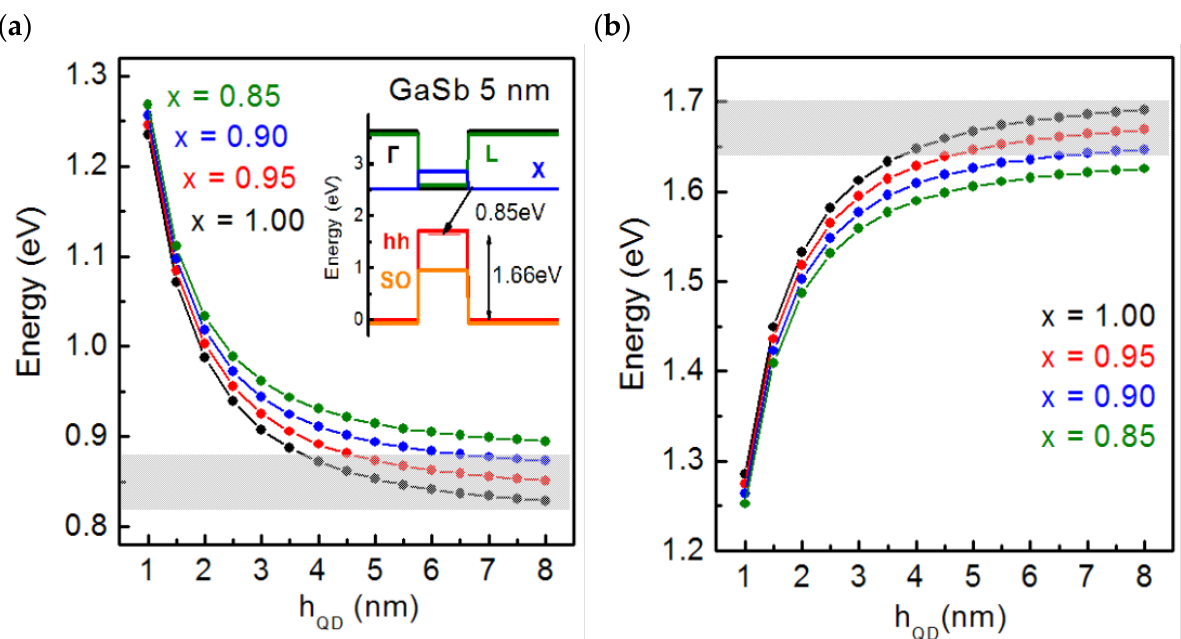
Figure 10. ( a ) Calculated optical transition energy dependences on the Ga x Al 1 − x Sb/AlP SAQD height for various alloy composition values. In the inset is the band diagram for GaSb/AlP SAQDs with a height of 5 nm. The shaded area corresponds to the SAQD optical transition energy values obtained from experimental PL data. ( b ) Calculated E loc dependences on the Ga x Al 1 − x Sb/AlP SAQD height for different alloy compositions. The shaded area corresponds to the E loc values obtained from a comparison of the PL data and the calculation results. The calculated dependences of the SAQD optical transition energy are shown in Figure 10a. An increase in the SAQD sizes leads to a decrease in the optical transition energy, which is explained by the quantum confinement effect. An increase in the content of Al atoms in the SAQD composition leads to an increase in the optical transition